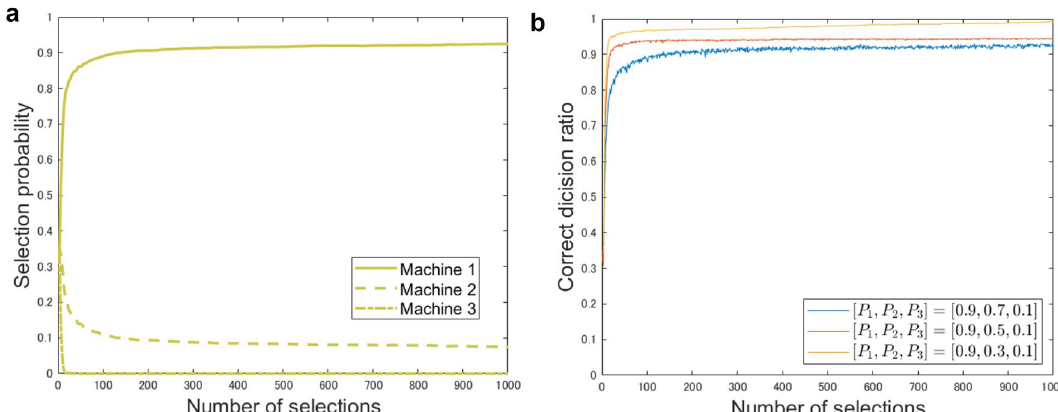
Figure 3. Simulation results for solving 1-player 3-armed bandit problem with OAM system and softmax policy. (a) Probability of selecting each machine over 1000 times when 1000 repetitions. (b) Correct decision rate over 1000 repetitions in different reward